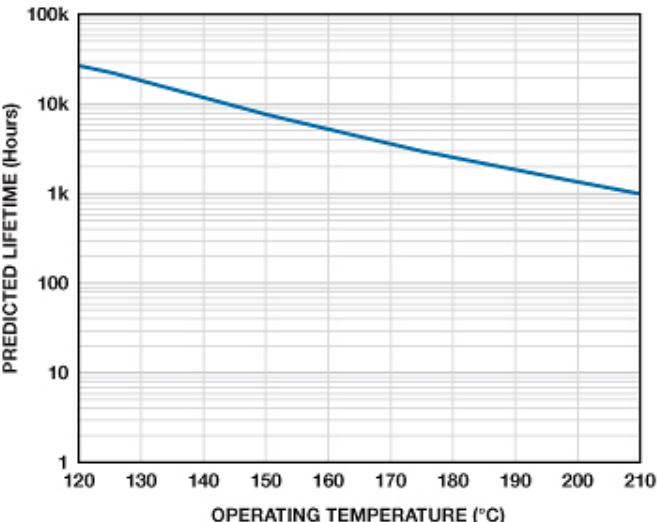
Figure 1. Lifetime degradation of AD8229 electronic device as a function of the operating temperature [6].